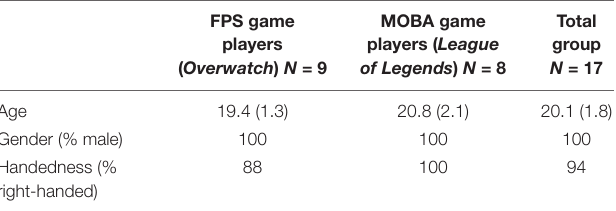
TABLE 1 | Demographic information and performance on outcome variables broken down by type of game